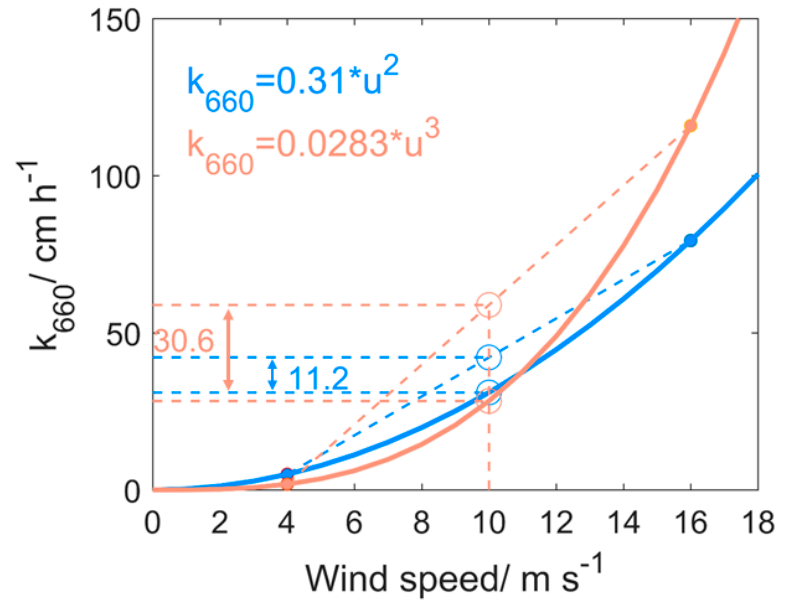
Figure 1. Conceptual diagram representing the bias in gas transfer velocity (k) estimates associated with averaging wind speed variability (adapted from [32]). The quadratic and cubic relations are in blue and orange, respectively.